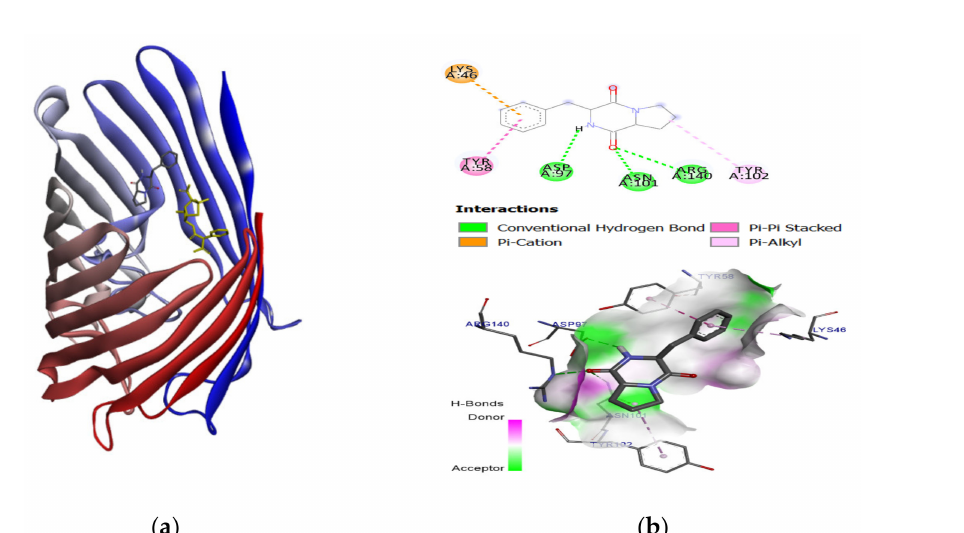
Figure 3. ( a ) In silico interaction of selected ligand pyrrolo (1,2-F) pyrazine-1,4-dione,2,3,6,7,8,8A- hexahydro-3-(phenylmethyl) in stick mode, carbenicillin in yellow and target protein, OmpF porin (4GCQ) ( b ) 2D (top) and 3D level interaction (bottom) of the best-docked complexes illustrate the mode of interaction of the amino acid in the binding pocket. Non-polar hydrogens are not